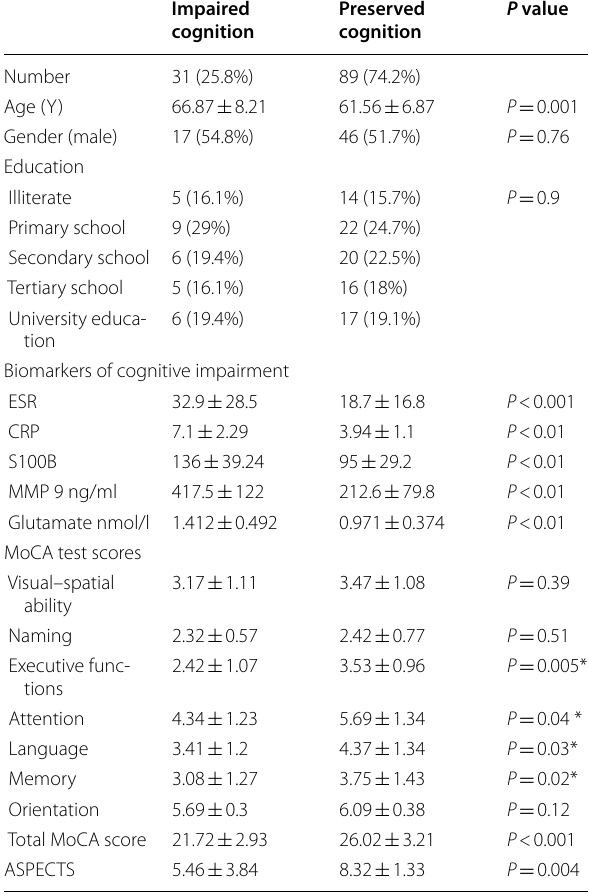
Table 2 Biomarkers of cognitive impairment and MoCA test scores in patients with cognitive impairment compared with patients with preserved